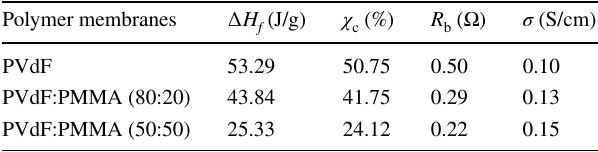
Table 1 Melting enthalpy (∆ H f ), crystallinity ( χ c ), bulk resistance ( R b ) and ionic conductivity ( σ ) of PVdF, PVdF/PMMA (80:20) and PVdF/PMMA (50:50) nanofibrous membranes Polymer membranes